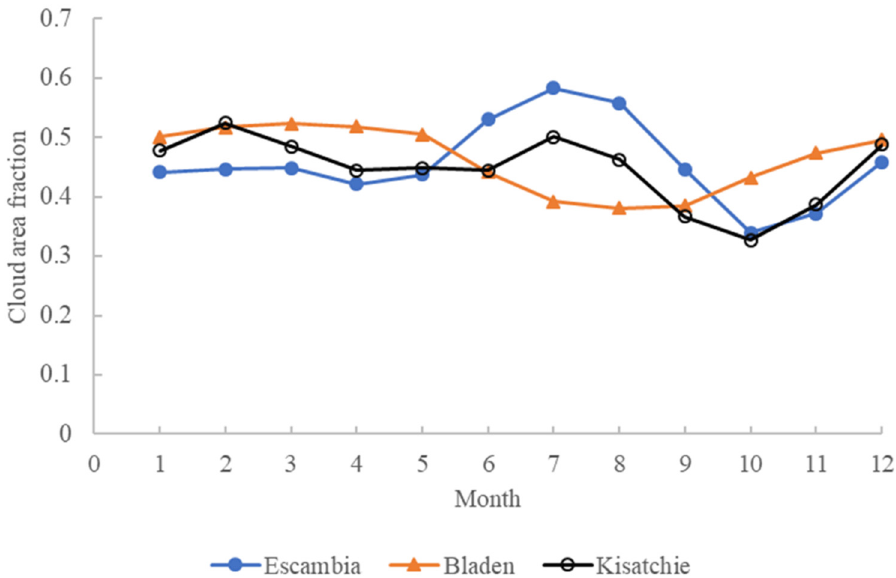
Figure 9. The integrated monthly total cloud area fraction in Escambia, Bladen, and Kisatchie.